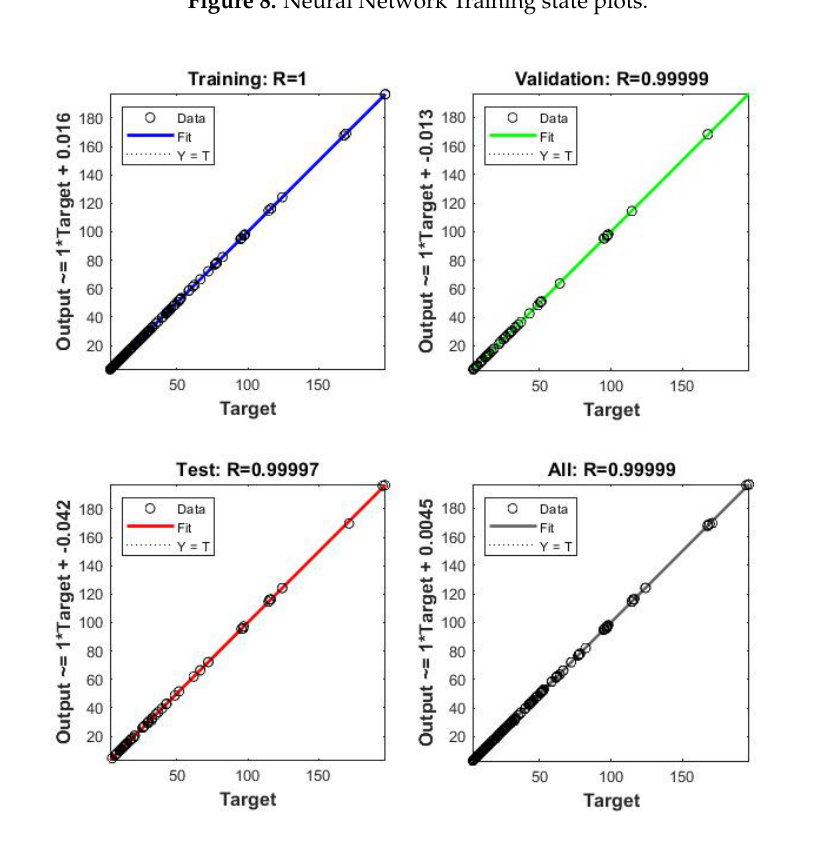
Figure 9. Neural Network Regression